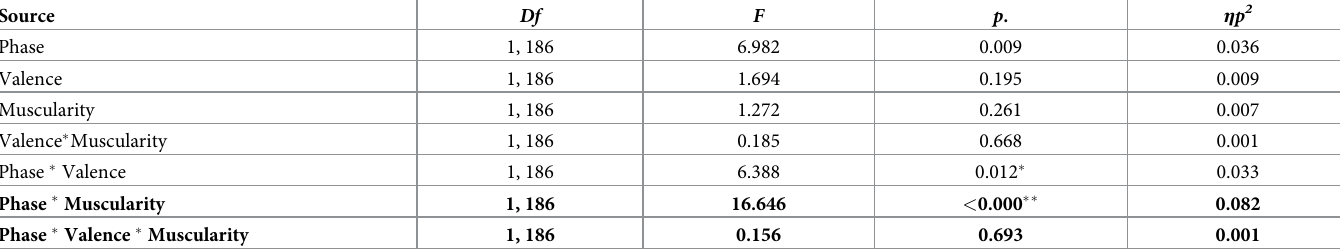
Table 2. Tabulated values for mixed ANOVA with phase (pre- versus post-manipulation preference for muscularity scores) as the repeated measures variable, and model muscularity (high muscle mass or low muscle mass) and model valence (aspirational or neutral) as between-participant factors. Critical tests of our hypothe- ses are shown in